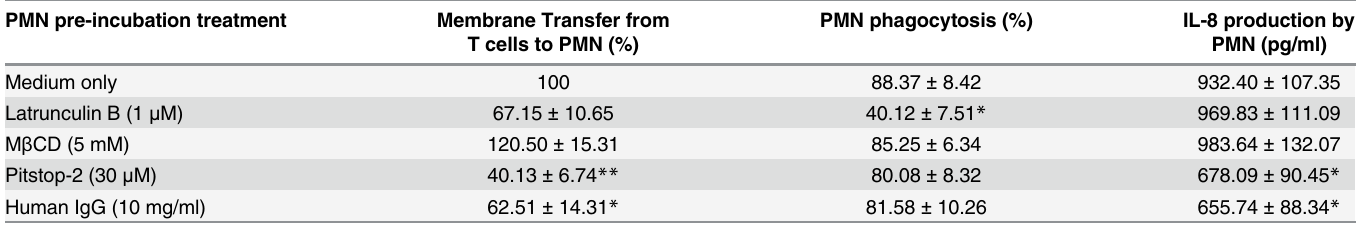
Table 2. Effects of different membrane integrity inhibitors on total membrane transfer from PKH26-labeled T cells to PMNs and PMN functions after 1 h pre-incubation detected by flow